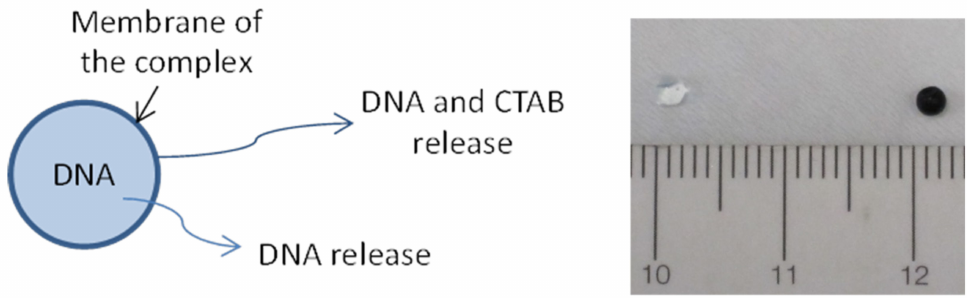
Figure 1. Sketch of the studied delivery systems and, on the right side, a picture of PEG–DNA–CTAB and MWNT–DNA–CTAB gel particles, which were for two hours in the CTAB solution. The size of the gel particles was the same, as the DNA gel was added drop-wise to the CTAB